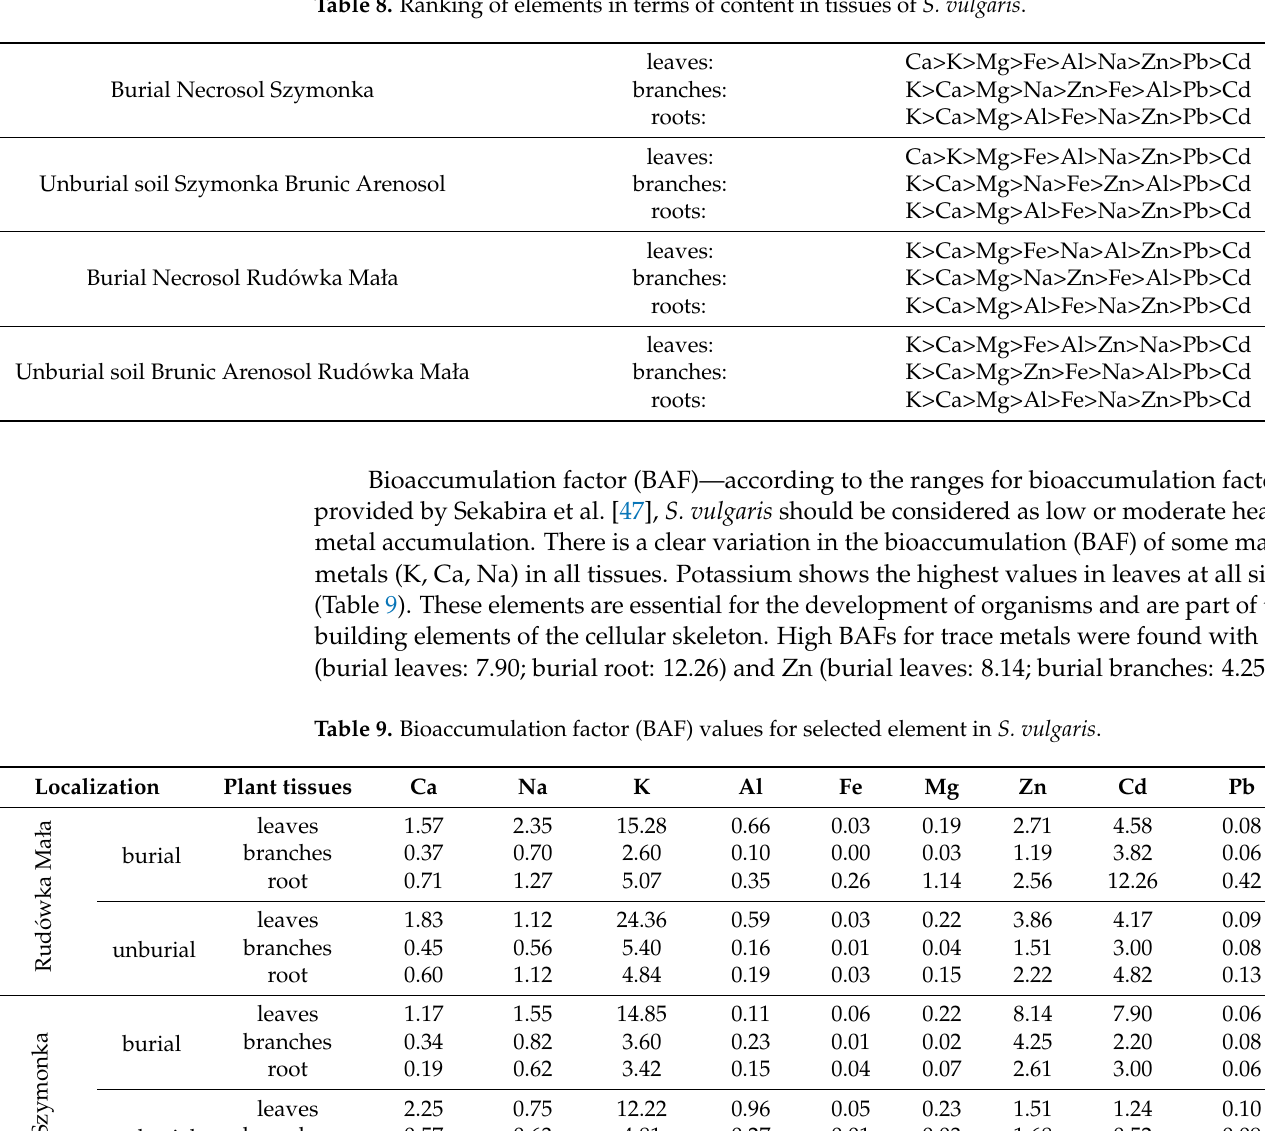
Table 8. Ranking of elements in terms of content in tissues of S. vulgaris .